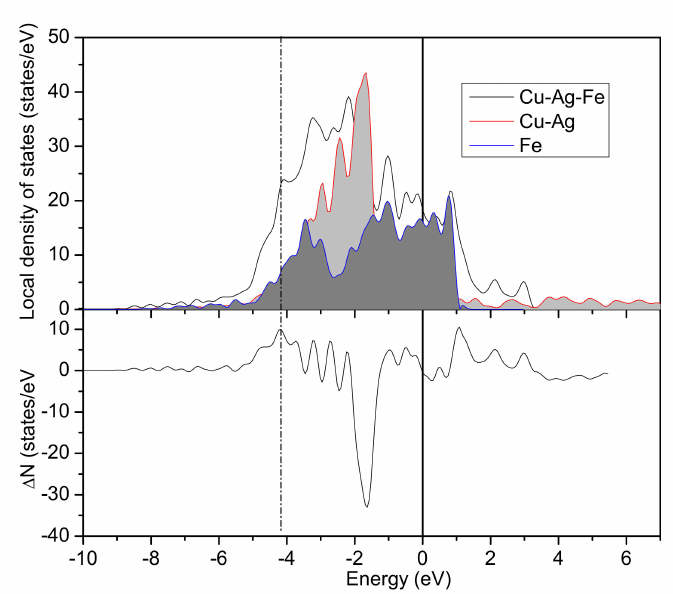
Figure 5. The LDOS of the binary Cu-Fe-Ag system; the Fermi energy is set to 0 eV. ∆ N is the di ff erence between the LDOS of the Cu-Ag / γ –Fe system and that of the Cu-Ag(100) system and the Fe(100) system. Compared with the LDOS analysis of the binary Cu / γ –Fe interface, in the ternary Cu-Ag / γ –Fe interface, the calculated charge number of the bonding states decreased from 10.79 to 10.00, indicating that the less charge transferred from Fe (Cu) to bonding states and the bonding strength decreases.